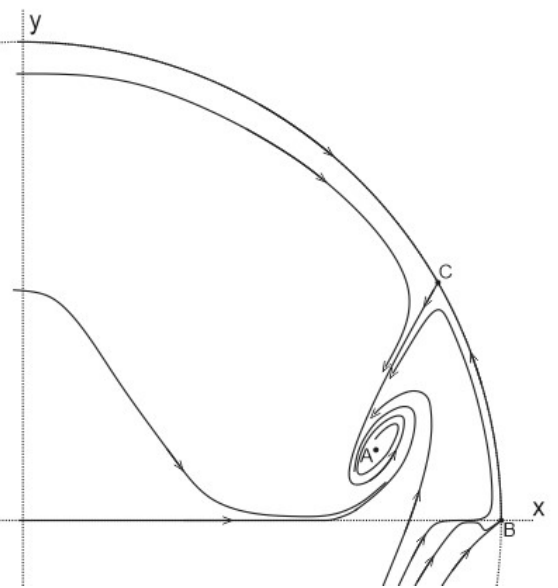
Figure 2. Phase portrait of system (8): the trajectories in the first quadrant are moving towards the stable singular point A or towards the stable limit cycle surrounding it. Some trajectories from the fourth quadrant are approaching the singular point at infinity, point B